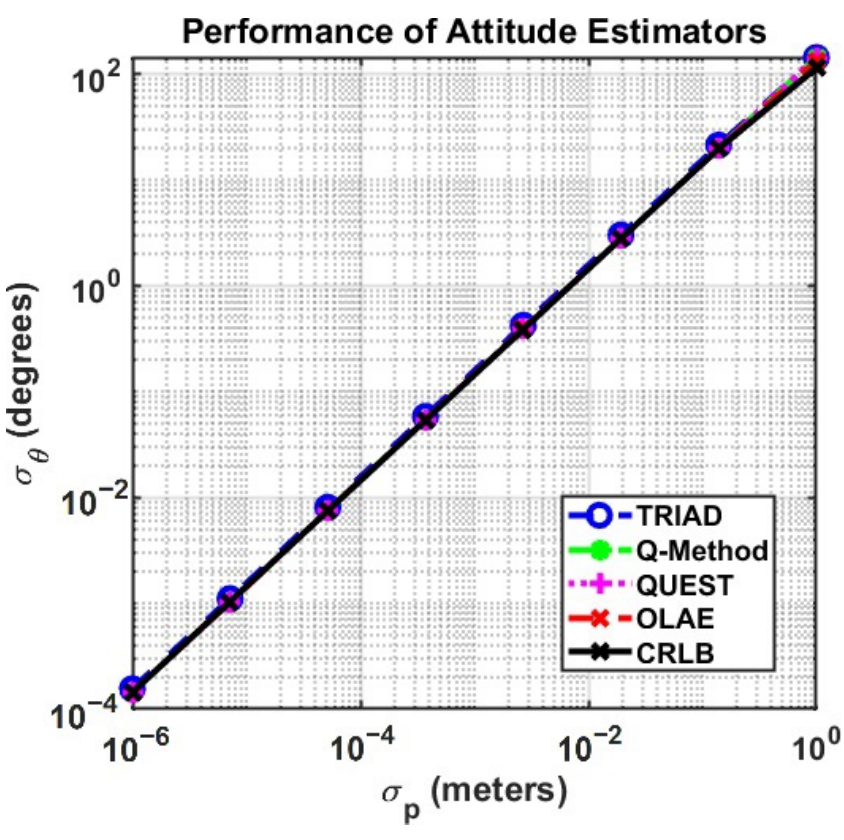
Figure 8. The 3D orientation CRLB vs. positioning precision for several attitude estimators.